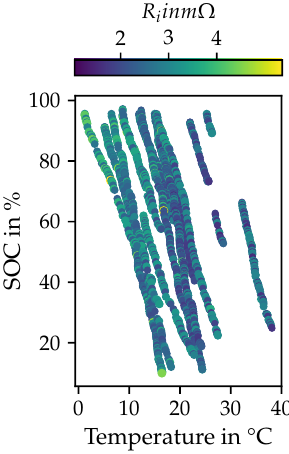
Figure 7. All cells and their capacities derived from one charging record.